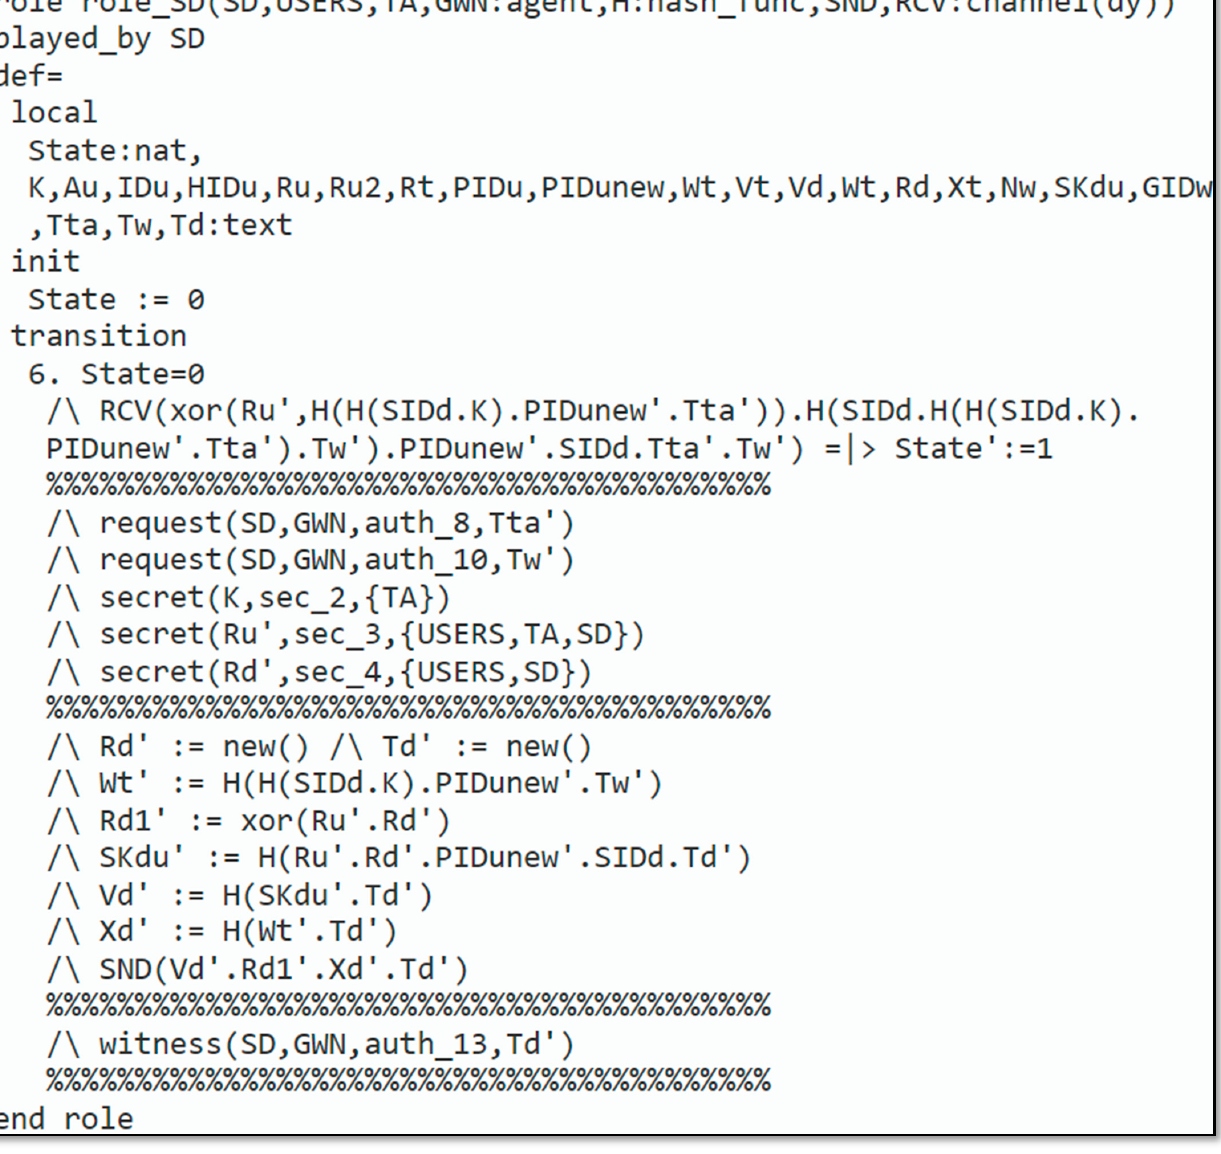
Figure 4. Role specification for a smart device.